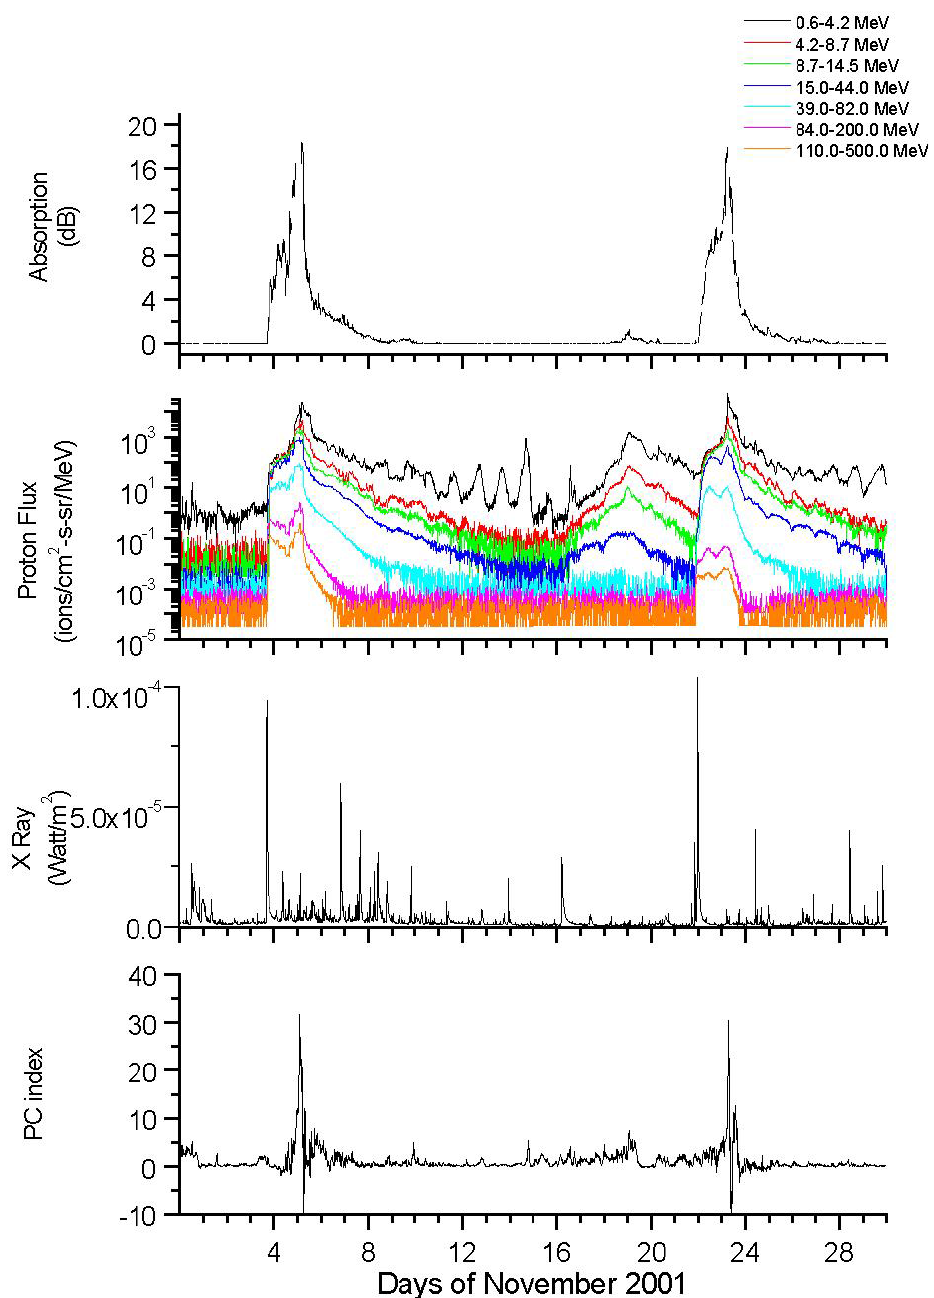
Fig. 1. Variation of ionospheric absorption, differential solar protons flux, solar X-rays (0.1–0.8nm), PC index during November 2001 (from top to